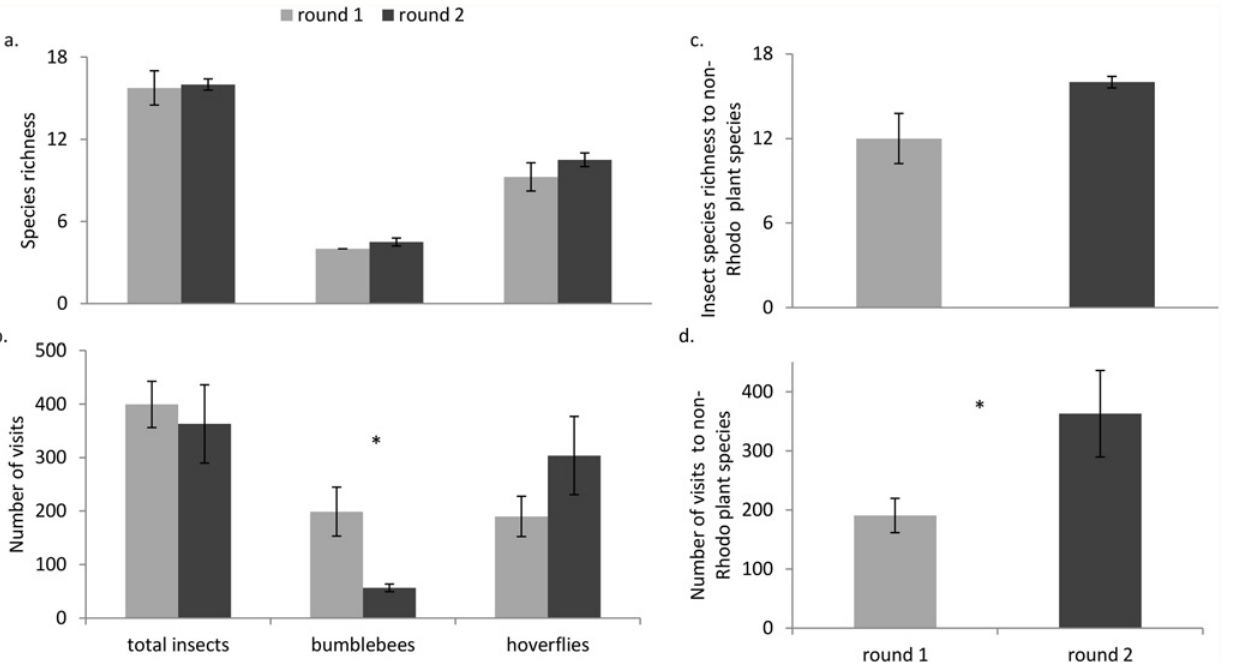
Fig 3. Flower-visitor species richness and abundance data Flower-visitor species richness and abundance during R . ponticum flowering (round 1, light grey bars) and after the cessation of flowering of the invasive (round 2, dark grey bars). Comparison between round 1 and 2 of a.) total insect, bumblebee, and hoverfly species richness and b.) number of visits of total insects, bumblebees, and hoverflies, c.) insect species richness to non- Rhododendron plants, and d.) number of visits to non- Rhododendron plants. Plots show mean values per round, averaged across the sites, and vertical bars show the standard error of each mean. Number of visits represents the number of floral units visited by insects, however insect abundance (number of individuals, not shown) followed the same patterns. Significant differences in the above parameters when comparing the two rounds of sampling are indicated by * (paired t-test, p < 0.05).